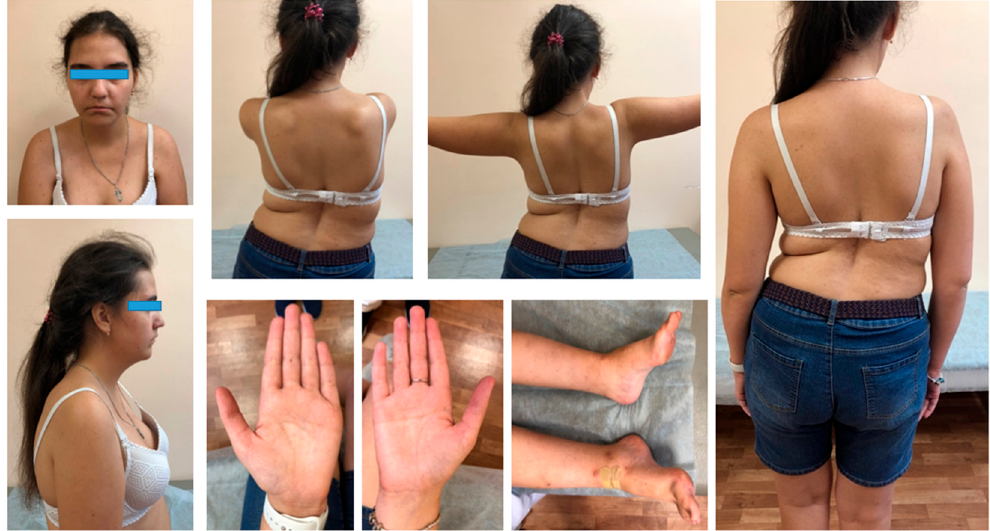
Figure 1. Patient at 17 years demonstrating downturned corners of the mouth, severe scoliosis, atrophy of pectoralis muscles and upper limb girdle muscles, mild clinodactyly of the right fifth finger, pes cavus, and asymmetric hip position.